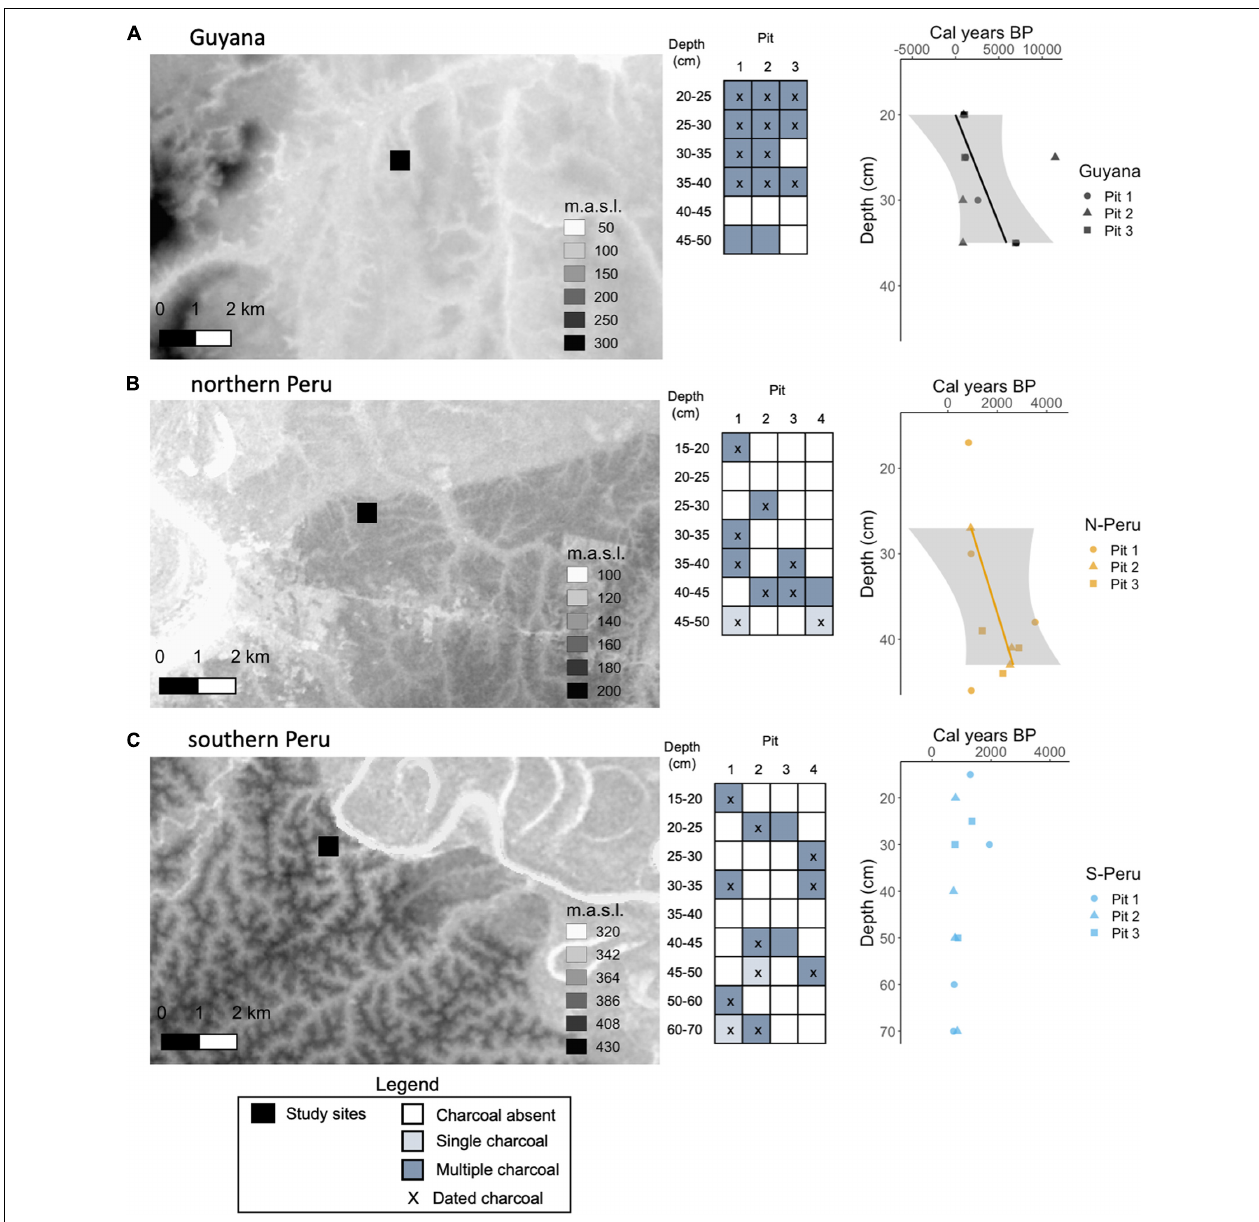
FIGURE 4 | Regional maps of site location (black squares) and elevation (m a.s.l., SRTM DEM). Shaded boxes in the table show macrocharcoal presence/absence by pit and soil depth (see the legend). No macrocharcoal was found above the first reported depth in each table. Bivariate plots of calibrated date (cal yrs BP) and sample soil depth (cm) for (A) Guyana, (B) northern Peru, and (C) southern Peru. Lines represent significant relationships for individual pits (Guyana Pit 1; N-Peru Pit 2; p < 0.1) and shading 95% confidence